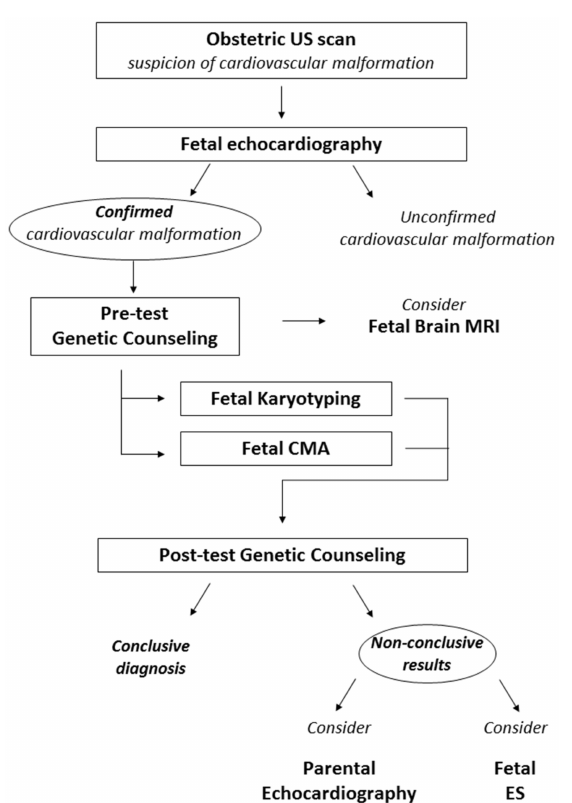
Figure 2. Proposed diagnostic workflow in fetal CVM. The suspicion of a cardiovascular